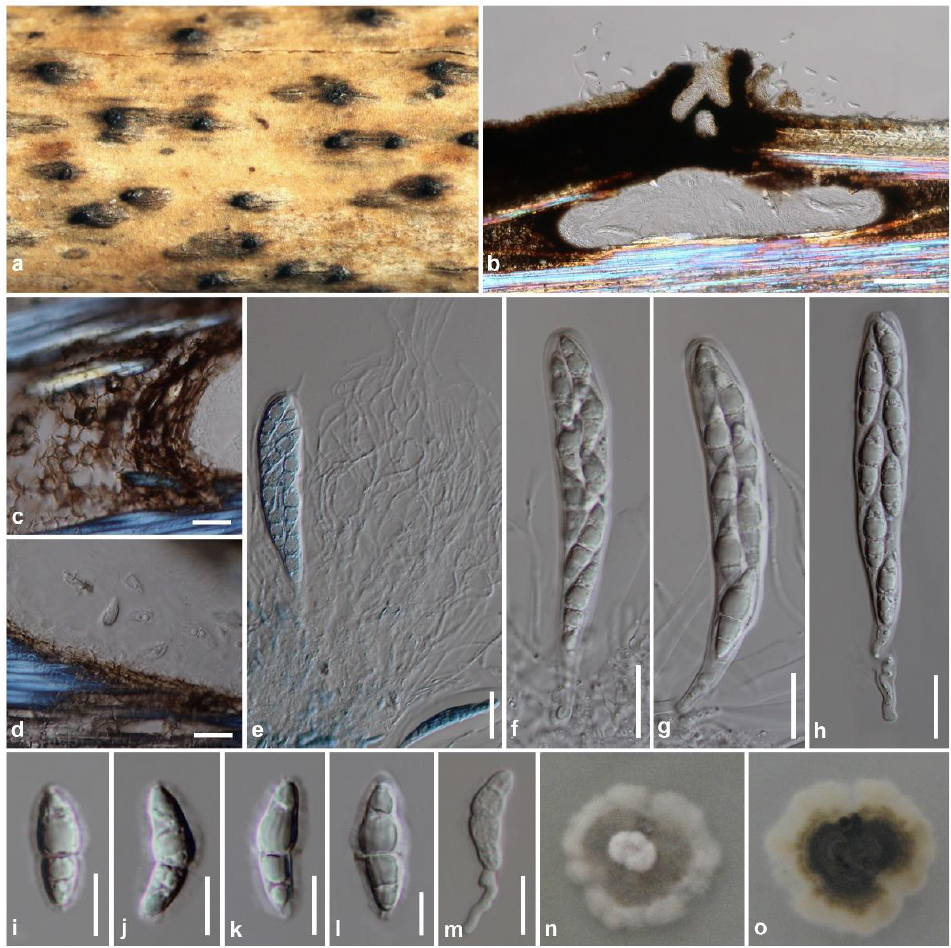
Figure 5. Anastomitrabeculia didymospora (MFLU 11-0233). ( a ) The appearance of ascomata on the host surface; ( b ) Vertical section of ascoma with ostiolar neck; ( c , d ) Peridium; ( e ) Pseudoparaphyses stained in cotton blue; ( f – h ) Asci; ( i – l ) Ascospores; ( m ) Germinating ascospore; ( n , o ) Culture characteristics on PDA after two weeks (( n ) = from above, ( o ) = from below). Scale bars: ( b ) = 100 μm, ( c – h ) = 20 μm, ( i – m ) = 10 μm.